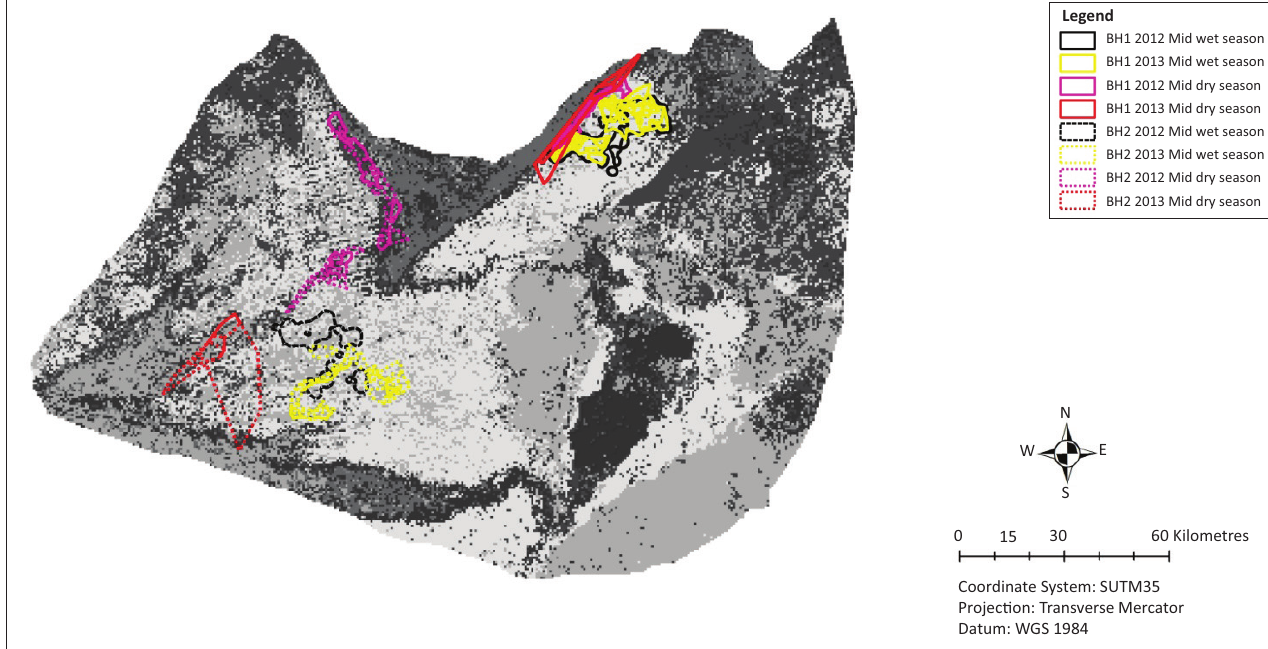
FIGURE 6: Movement patterns of buffalo 1 (BH1) and 2 (BH2) in the mid wet and mid dry season of 2012 and 2013, in relation to